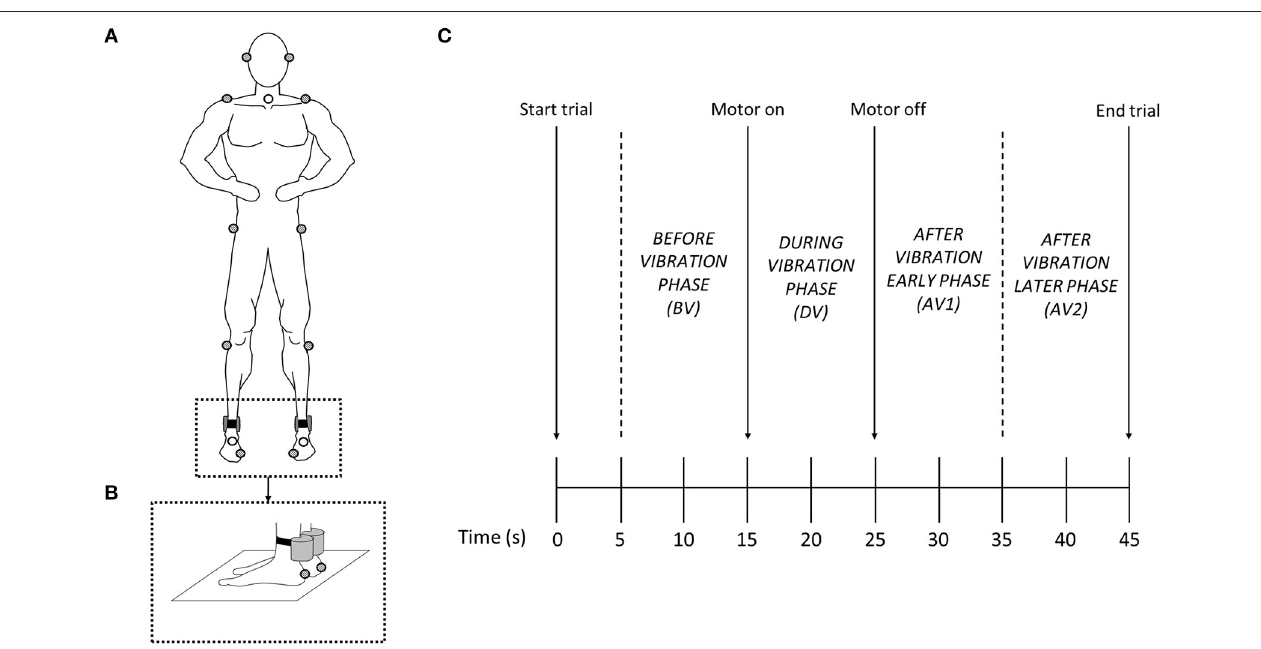
FIGURE 1 | (A) Sketch of the body landmark marker dispositions. (B) Detail of the vibrator collocations. (C) 45-s trial timeline indicating when vibration was applied to the participant (motor on—motor off) and the 10-s phases used to calculate variables. calibrated before the data collection with a mean error of 0.338 ± 0.040 mm. Reconstruction of the 3D markers was done using the software Smart Tracker (BTS Bioengineering S.p.A., Milan,